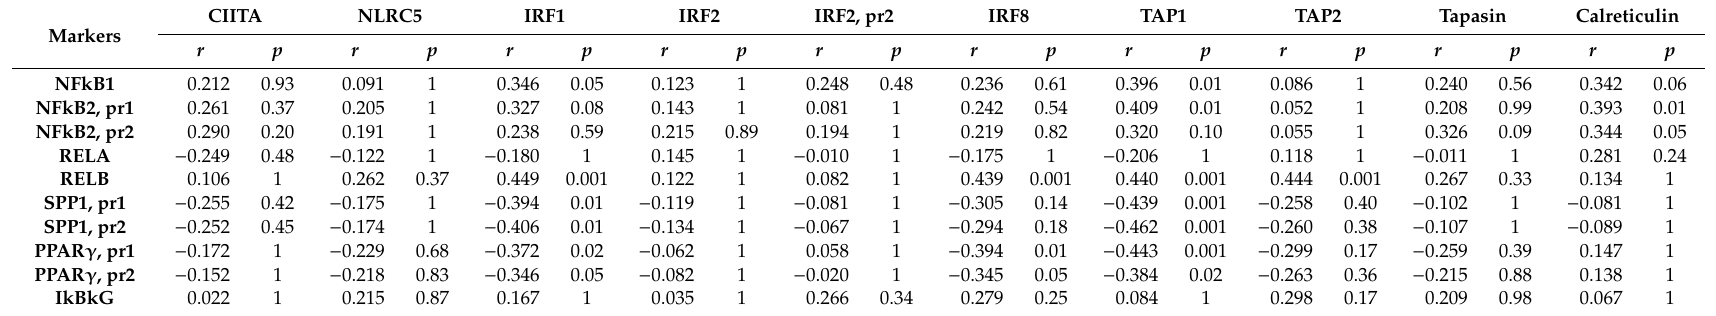
Table 2. Correlation between mRNA expression of NFkB pathway molecules and the antigen-presenting machinery and known regulators of HLA Class I expression, in a cohort of 64 primary UM. r = two-tailed Spearman correlation coe ffi cient. p ≤ 0.05 is considered significant. Bonferroni correction was applied.